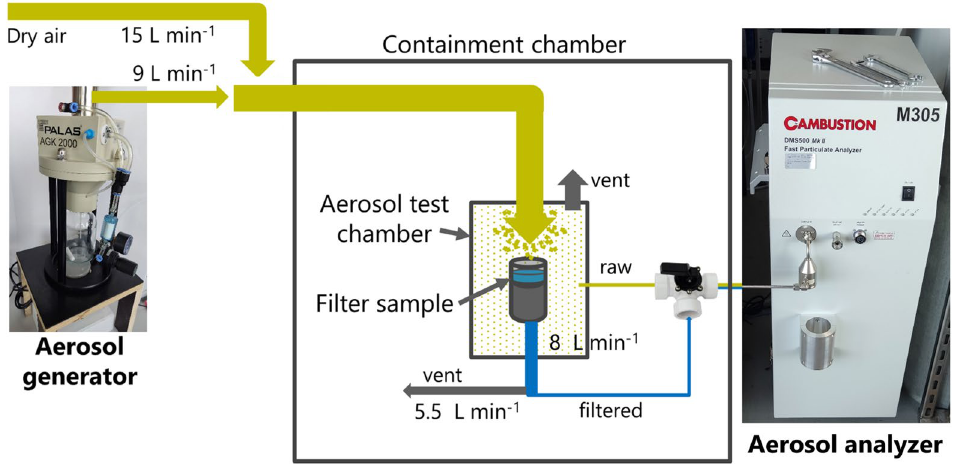
Figure 8. Schematic description of the filtration efficiency bench. The virus or NaCl solution was placed in the aerosol generator. A constant airflow containing viral or salt particles was generated through the specimen based on DIN 14683. The particle size distribution was measured in the particle